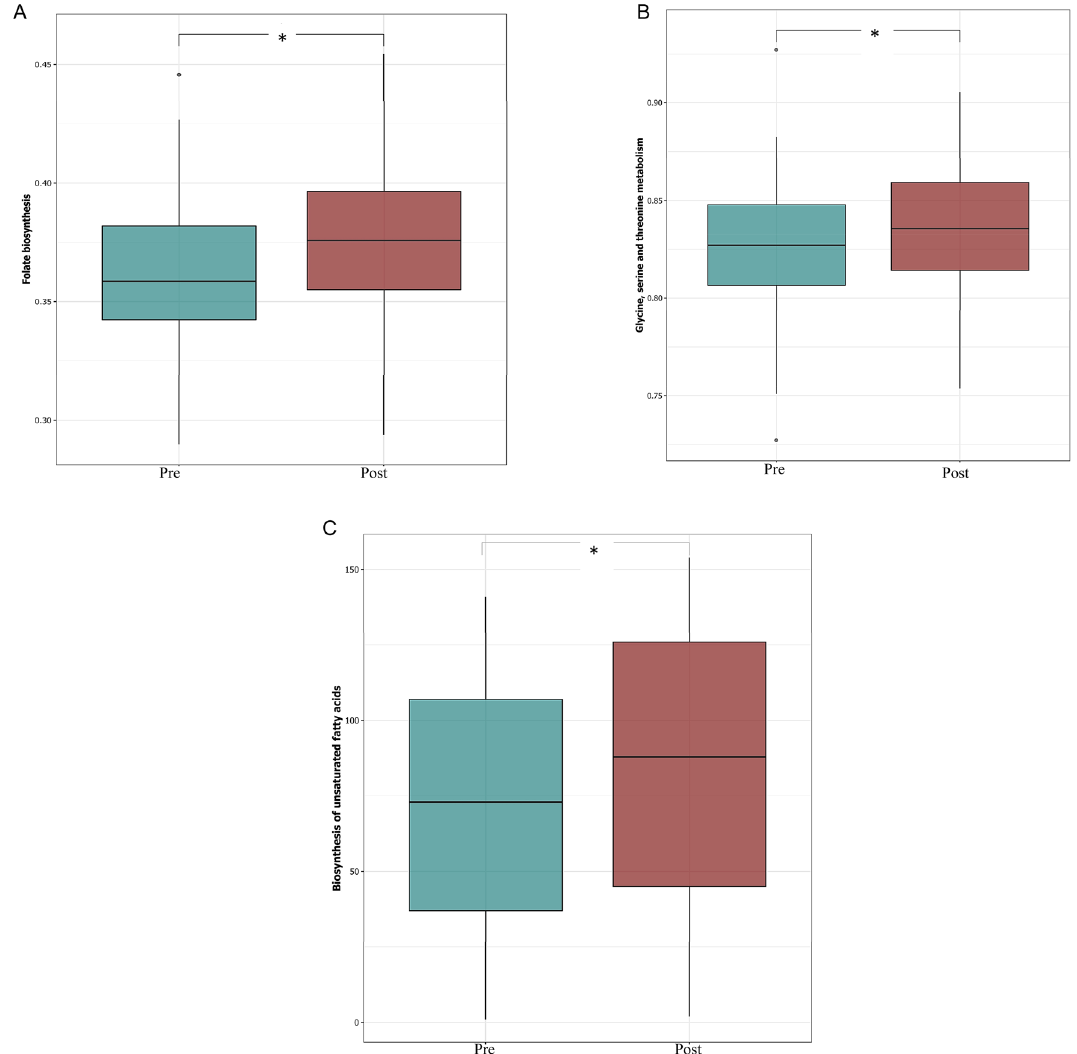
Figure 6. Inferred gut microbiome functions by PICRUSt from 16S rRNA gene sequences pre- and post- vitamin D supplementation. Difference in predicted functions of genes involved in ( A ) biosynthesis of folate; and ( B ) glycine, serine and threonine metabolism ( C ) biosynthesis of unsaturated fatty acids (Mann– Whitney* P < 0.05;). The figure was generated using (RStudio v 1.2 with R v 3.6) 87